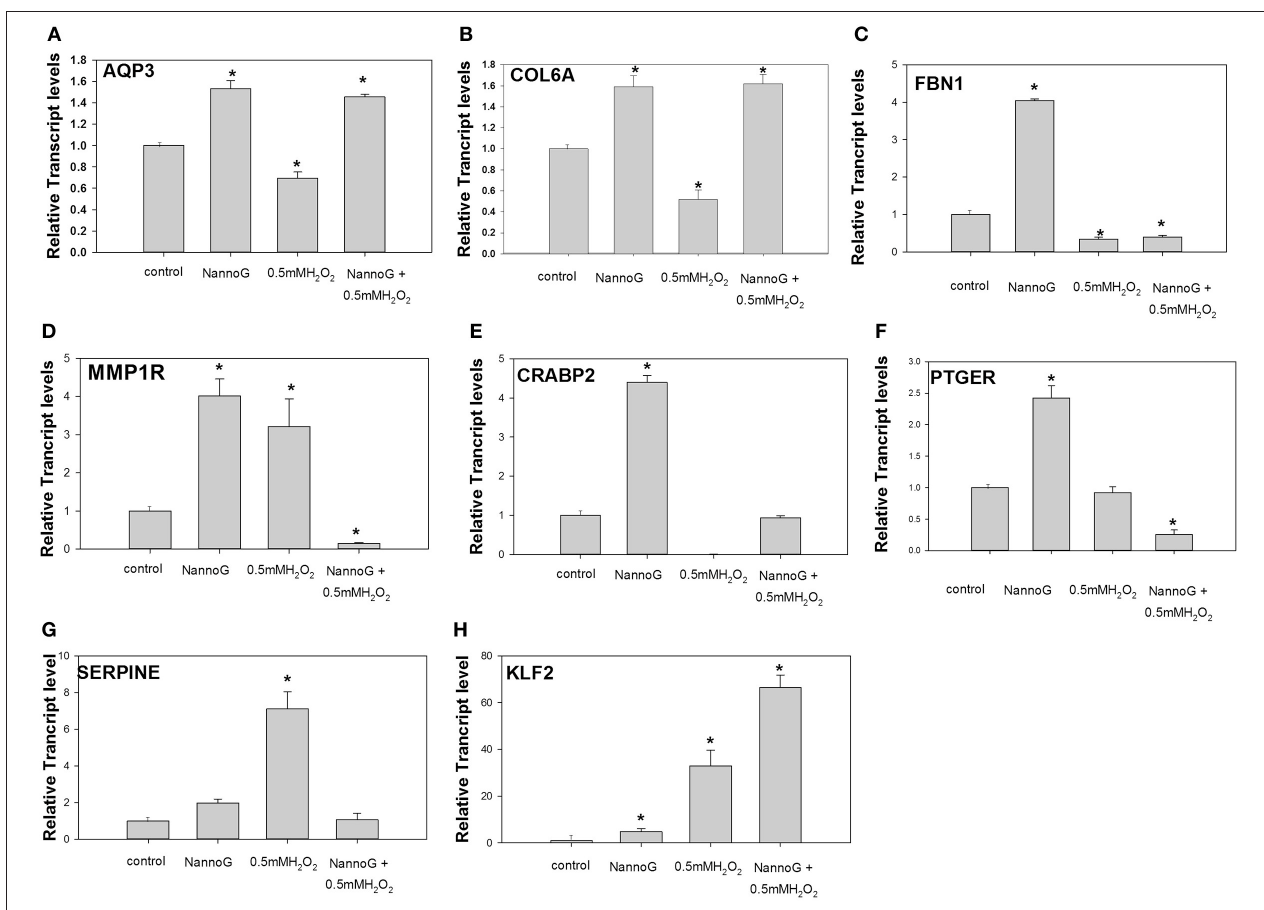
FIGURE 6 | Relative transcript accumulation of: (A) AQP3, (B) COL6A1, (C) FBN1, (D) . MMP1R, (E) CRABP2, (F) PTGER2, (G) SERPINE-1, (H) KLF2. The experimental conditions are: control cells, cells treated with H 2 O 2 0.5 mM, cells treated with NannoG (408 µ g/ml) and cells treated with NannoG first and then with H 2 O 2 (0.5 mM). * p < 0.05 significantly different from